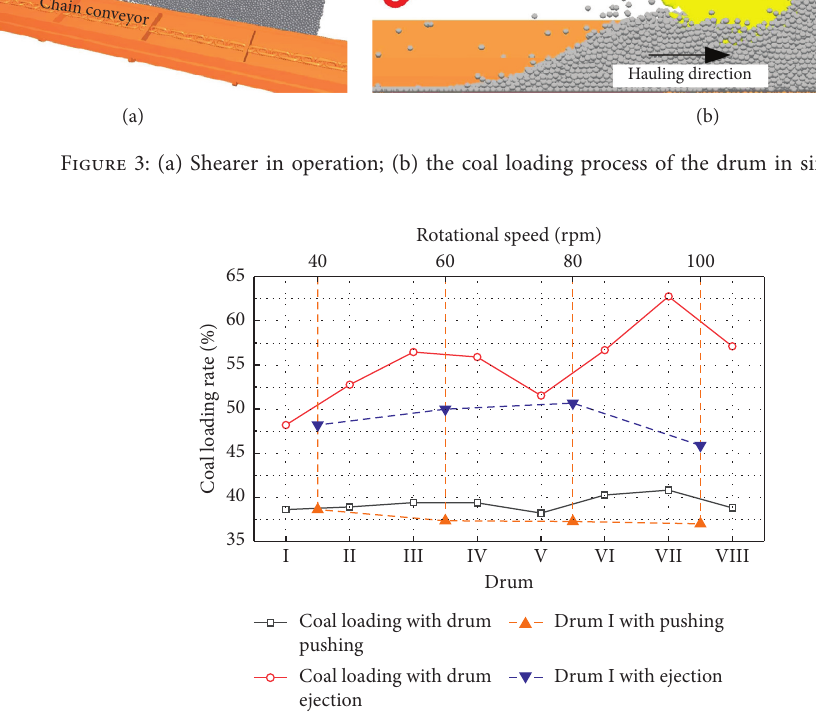
Figure 4: The comparison of different coal loading methods. Table 2: The parameters of the particle in the